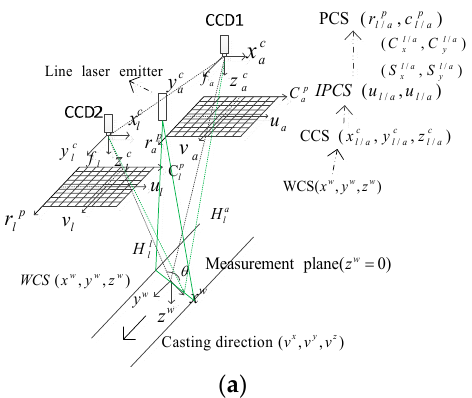
Figure 4. Laser stripe imaging features at different CCD imaging states. ( a ) Short CCD integral time; ( b ) Optimal laser imaging; ( c ) Long CCD integral time.